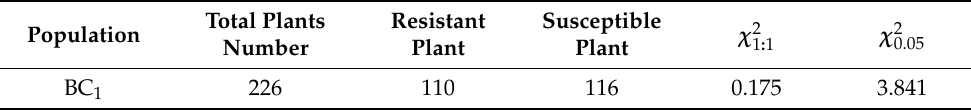
Table 1. Genetic analysis of resistance to spinach downy mildew in the BC 1 population. Total Population